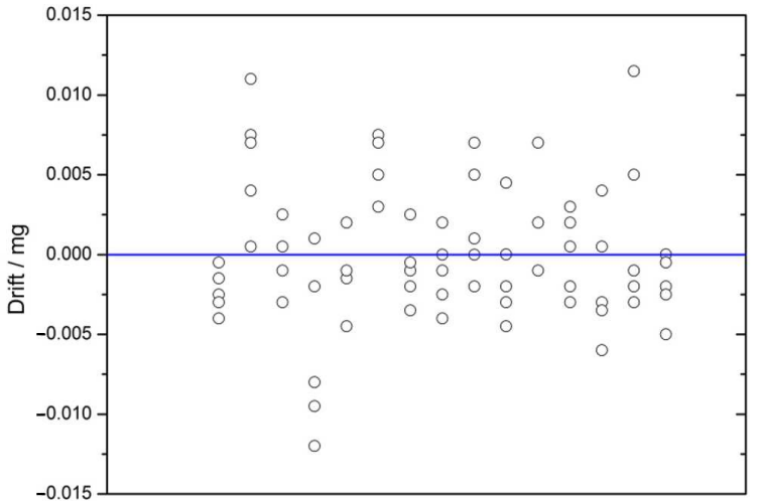
Figure 13. Differences of readings obtained from drift elimination procedures. Blue line is the mean value.